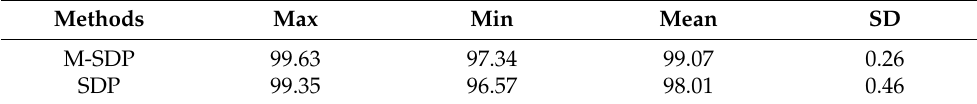
Table 8. The testing results using M-SDP and SDP (%).